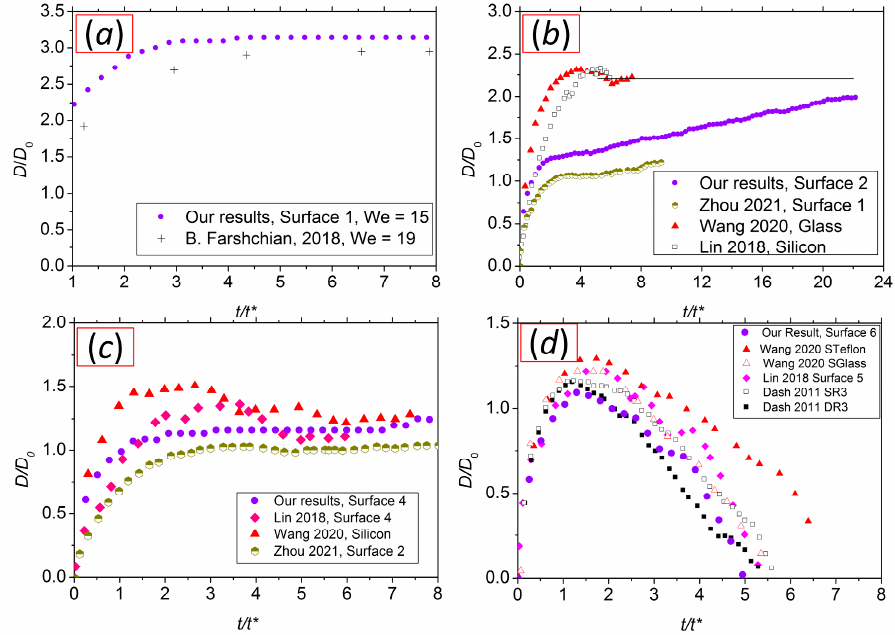
Figure 8. Comparison of experimental data on the dynamics of water droplets spreading on the ( a ) Superhydrophilic surfaces at We = 15–19, ( b ) surfaces with CA = 20°–40° at We = 1.5–4, ( c ) surfaces ( a ) Superhydrophilic surfaces at We = 15–19, ( b ) surfaces with CA = 20 ◦ –40 ◦ at We = 1.5–4, ( c ) surfaces with CA = 84°–110°, We = 1.5–4, ( d ) superhydrophobic surfaces CA = 140°–160°, We = 2–4 . with CA = 84 ◦ –110 ◦ , We = 1.5–4, ( d ) superhydrophobic surfaces CA = 140 ◦ –160 ◦ , We =